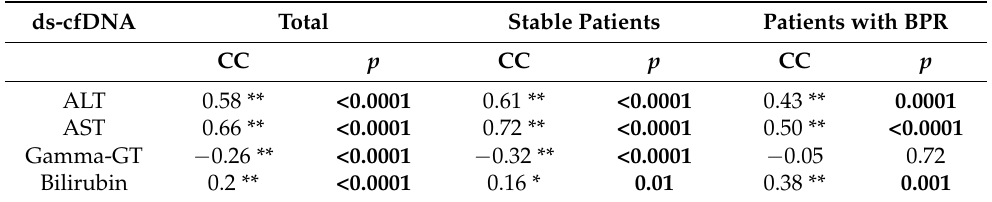
Table 3. Correlation between ds-cfDNA percentage and liver function markers for total population after TX, stable patients, and patients suffering BPR.